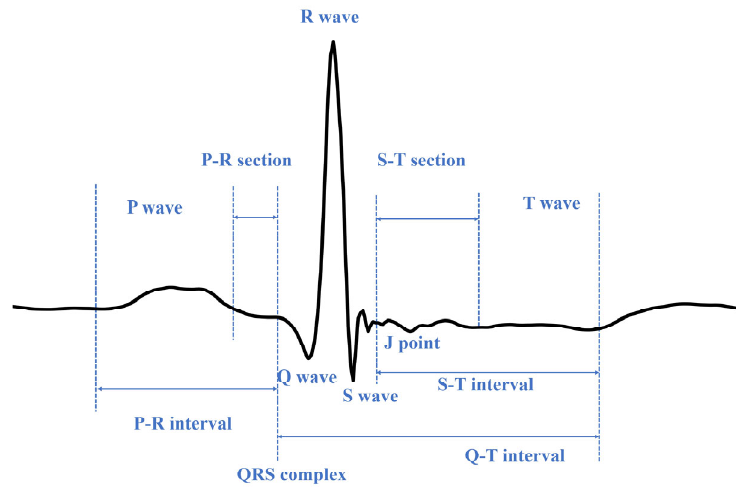
Figure 1. Schematic diagram of ECG beat.